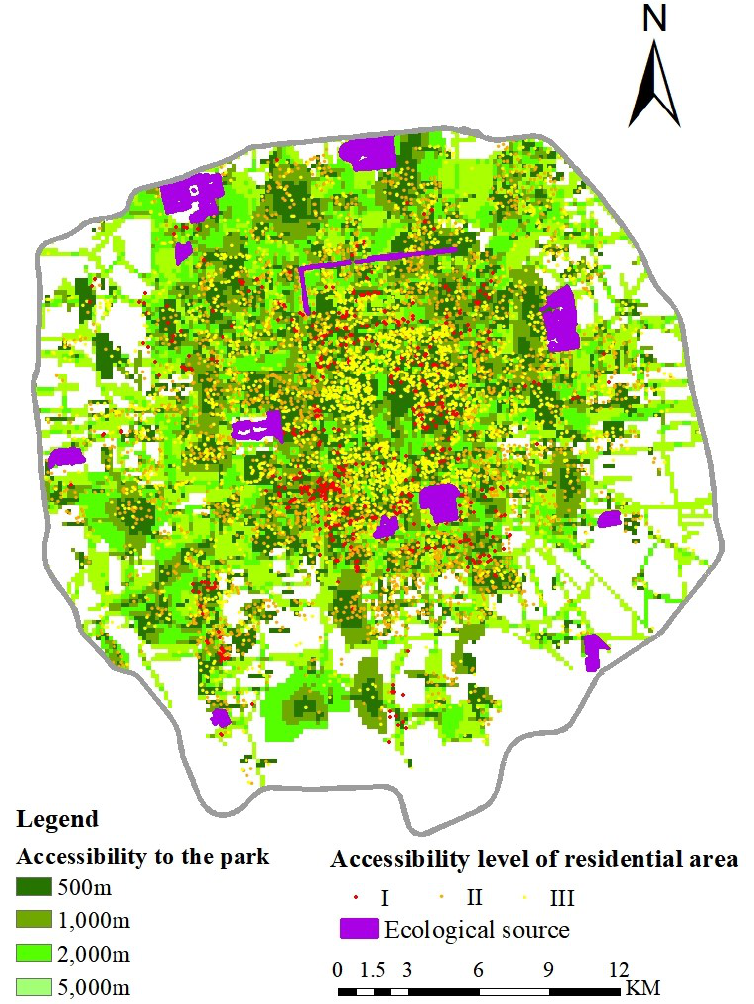
Figure 9. Accessibility analysis results.